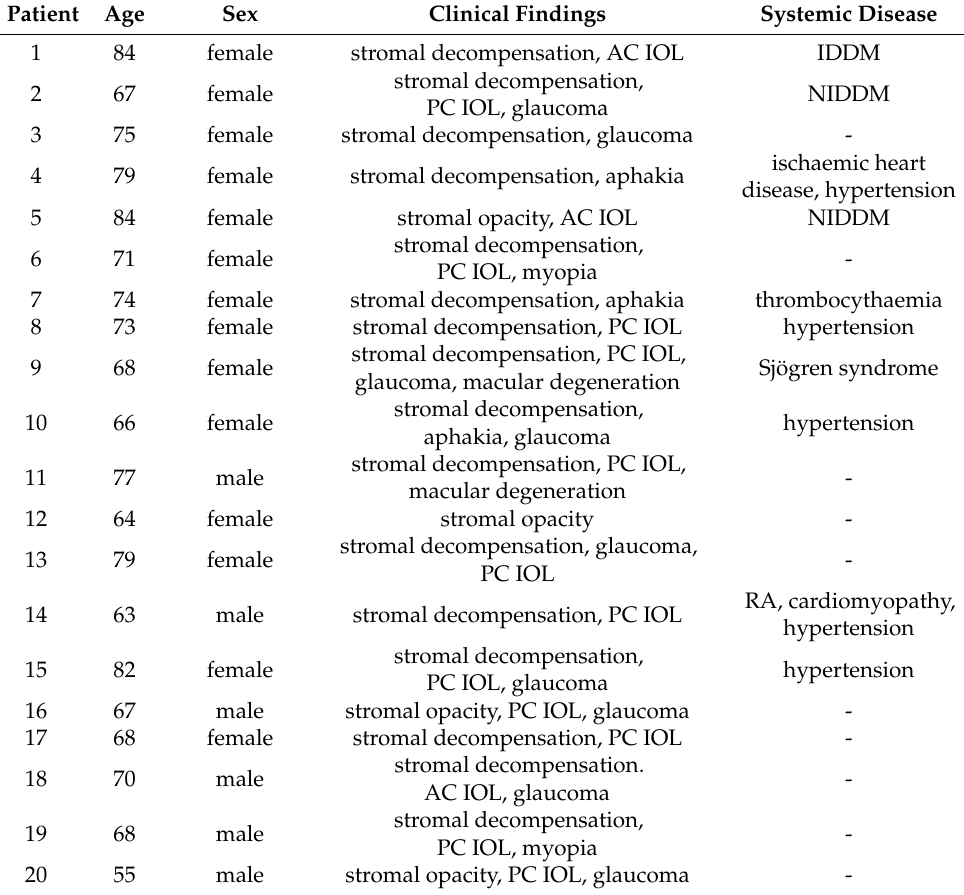
Table 1. Clinical characteristics of PBK patients.